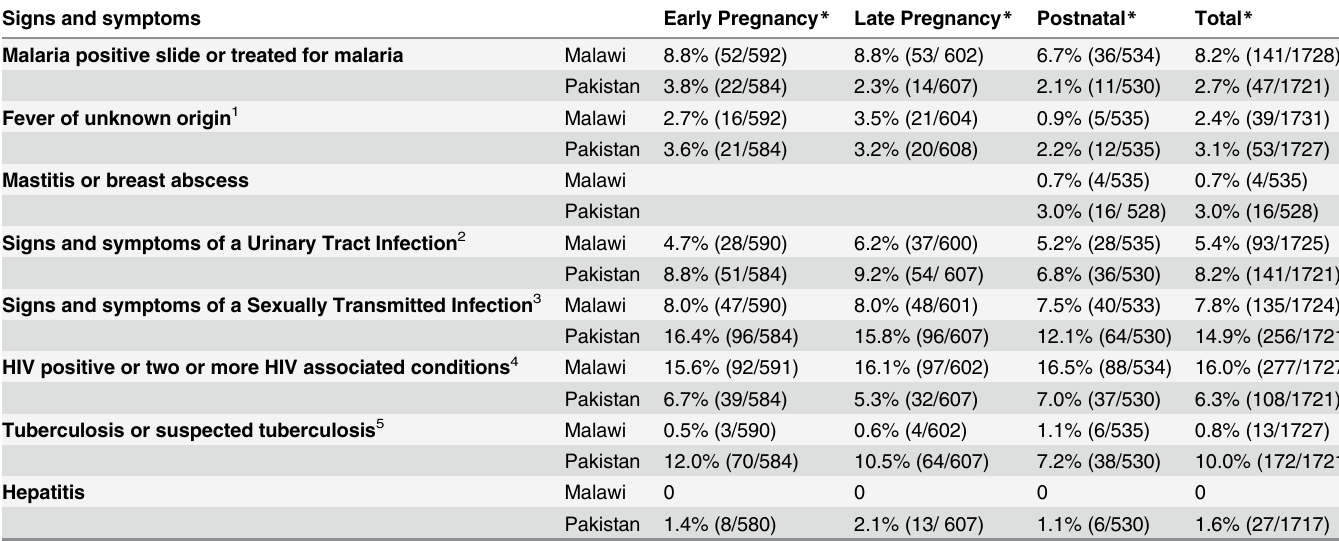
Table 3. Signs and Symptoms of Infective Morbidity.